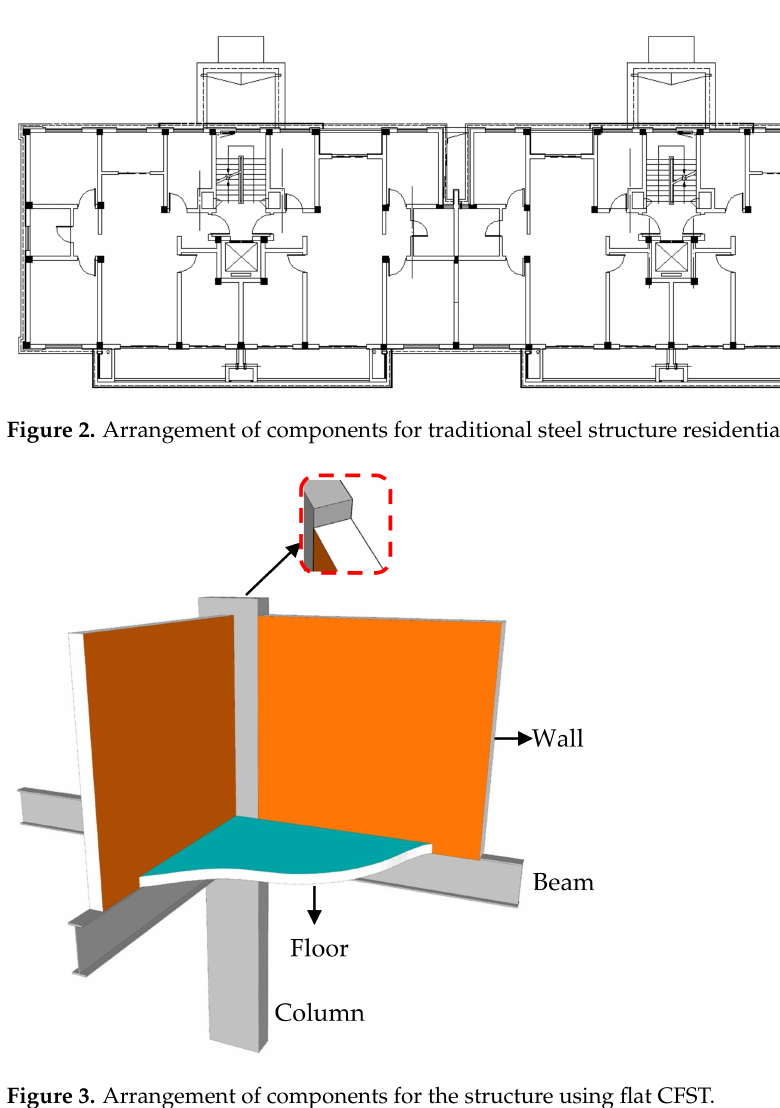
Figure 3. Arrangement of components for the structure using flat